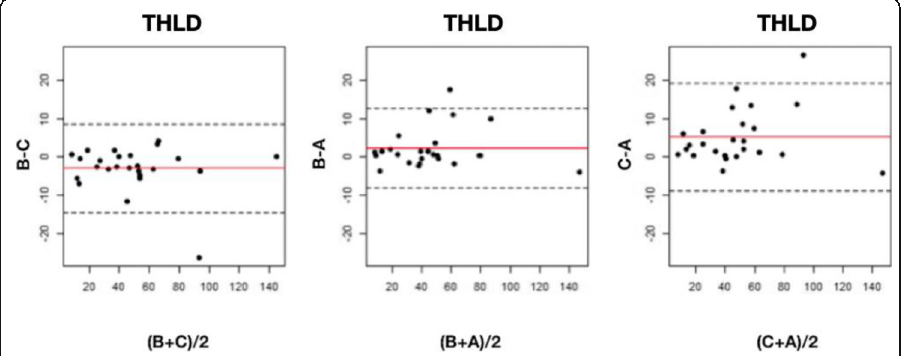
Fig. 2 Bland-Altman graph for non-tumoral doses (THLD) in grays. The red line represents the average of the differences between observers and the dotted line, the mean of the differences ± 2 standard